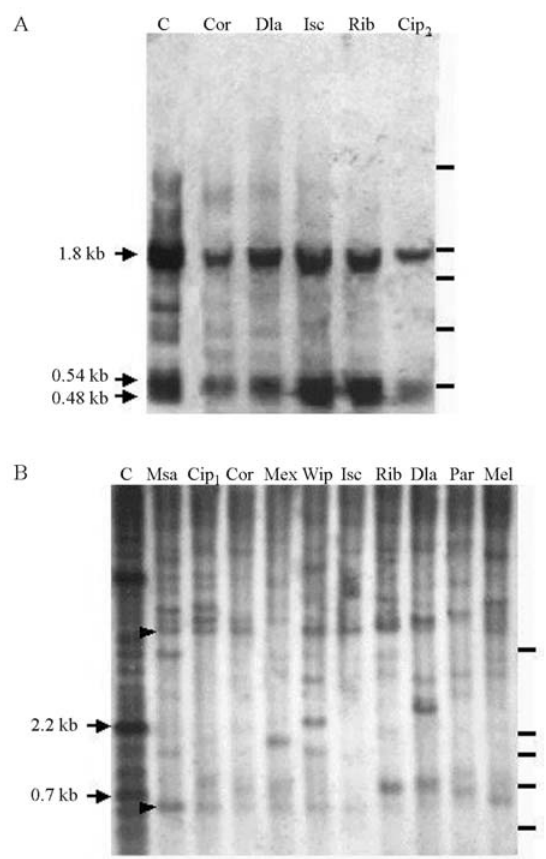
Figure 3 - Southern blot hybridization of genomic DNA from Drosophila willistoni strains probed with the complete sequence of Drosophila melanogaster P canonic element contained in the p (cid:2) 25.1 plasmid, lane C is D. melanogaster (Harwich strain). The Genomic DNA from the differ - ent D.willistoni populationswasdigestedwitheither Ava II(Figure3A)or Xho I (Figure 3B). Arrows indicate the fragments expected for D. melanogaster . Bars on the right represent the 1 kb Plus DNA Ladder (Invitrogen) fragments (5, 2, 1.65, 1 and 0.5 kb). Arrowheads indicate bands shared by more than one